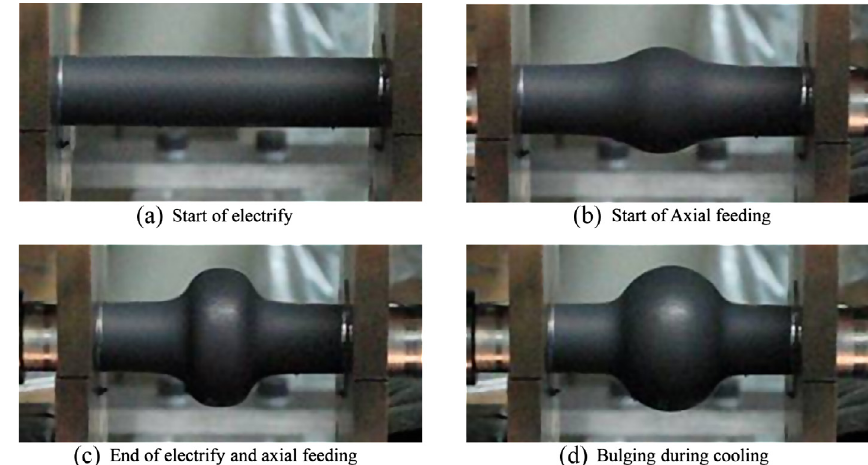
Figure 5. Deformation of tube in hot bulging for p 0 = 0.8 MPa, J = 76 A/mm 2 and v = 20 mm/s.